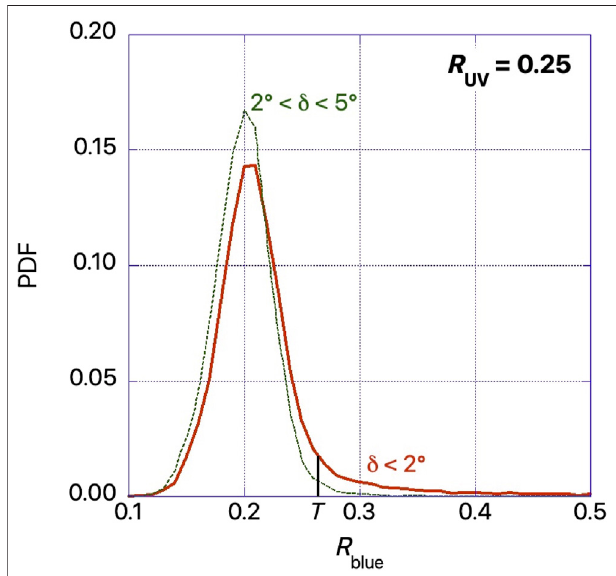
FIGURE 1 | Illustration of threshold selection for the detection of blue glints over non-desert land at pixels where the 388 nm UV re fl ectance is 0.25. The green solid and red dashed curves show the PDFs based on all EPIC imagestaken in 2018 for two different ranges of the glint angle ( δ ).Cloud glints often enhance re fl ectances < 2 ° , thus creating the long tail of the red curve. The black vertical bar indicates the T threshold value that was selected because it leads to a 10% false alarm ratio: The area to the right of this line [representinganintegralin Eq.(2) ]is10timessmallerunderthegreen(noglint) curve than under the red (glint-affected)